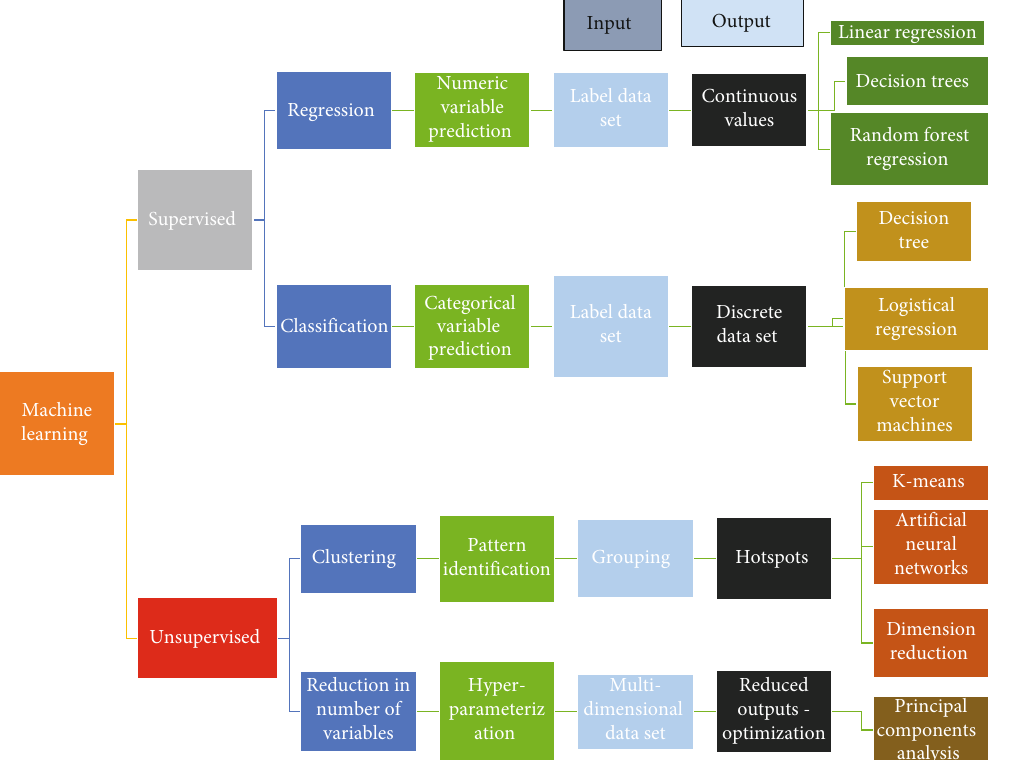
Figure 9: Machine learning algorithms and fl ow